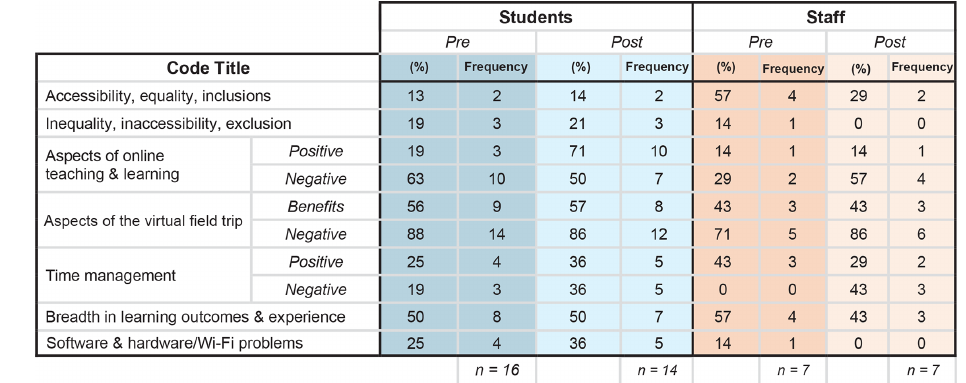
Table 2. Summary of qualitative text coding responses. The table shows the 10 codes and the frequency and percentage of coded occurrences; these data are plotted in Fig.